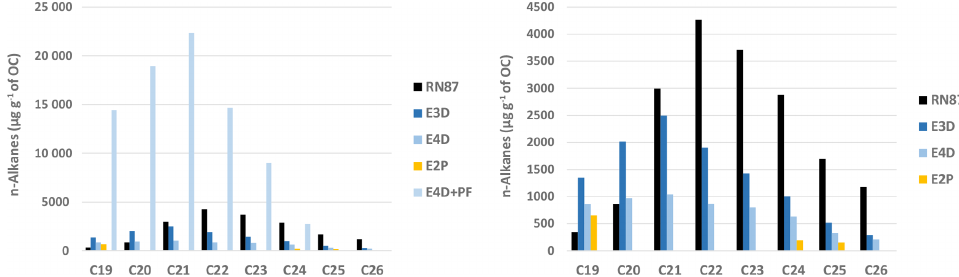
Figure 6. n -Alkane emissions normalized by OC emissions at the traffic site (RN87/E712) and from the exhaust of a diesel Euro 3 vehicle (E3D), a diesel Euro 4 vehicle (E4D), a diesel Euro 4 vehicle equipped with a particle filter (E4D + PF) (on the left only) and a Euro 2 petrol